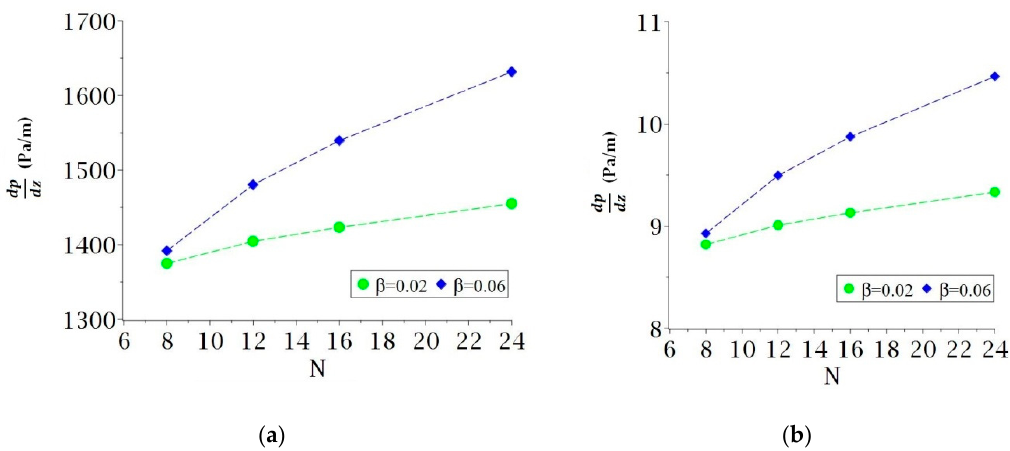
Figure 6. The pressure gradient is a function of the number of corrugations for different aspect ratios and fluid temperatures: ( a ) T = 29.22 ◦ C; ( b ) T = 260.3 ◦ C.